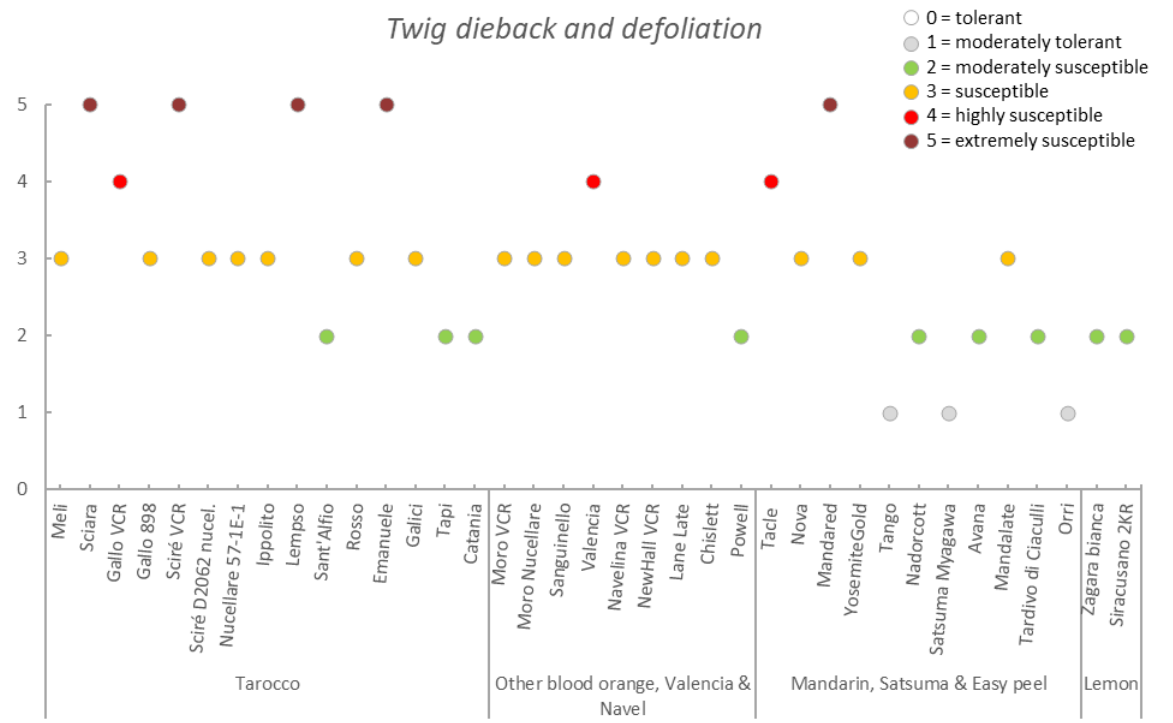
Figure 13. Maximum potential infection risk of twig dieback and defoliation recorded on detected Citrus germplasm. Data obtained from several Sicilian citrus production areas (from 1-to-20) within Citrus groups surveyed for three periods intercepting an eleven-year survey.